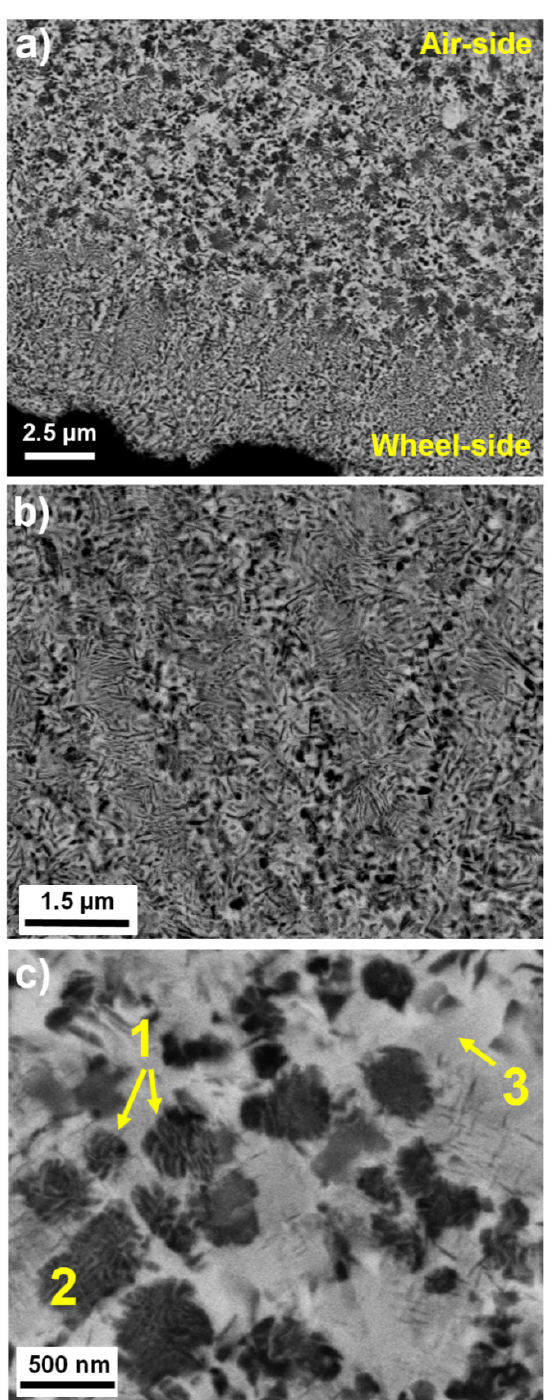
Figure 1. SEM-BSE image of the as-quenched Au 33 Fe 67 ribbon ( a ) cross section, ( b ) wheel side of the cross section, and ( c ) air side of the cross section; number 1 denotes bcc α (Fe) phase, number 2 denotes alternated grains of bcc α (Fe) and fcc (Au) phases; and number 3 denotes fcc (Au) phase.